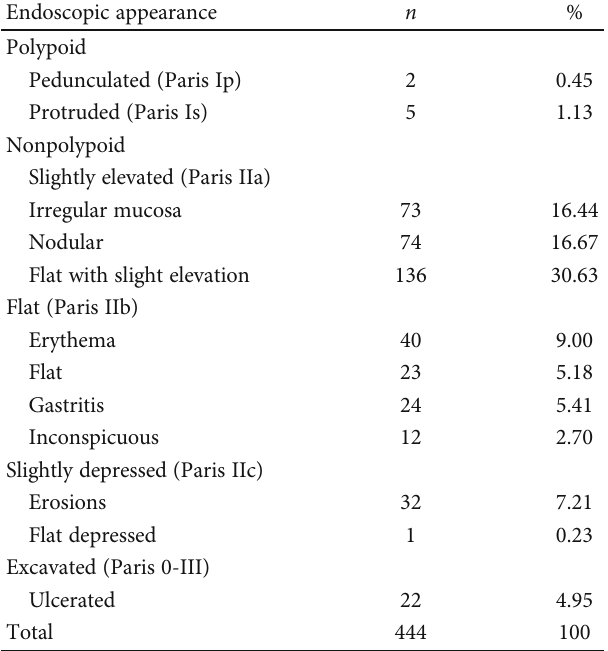
Table 5: Endoscopic appearances of LGIN in accordance with the Paris classi fi cation.